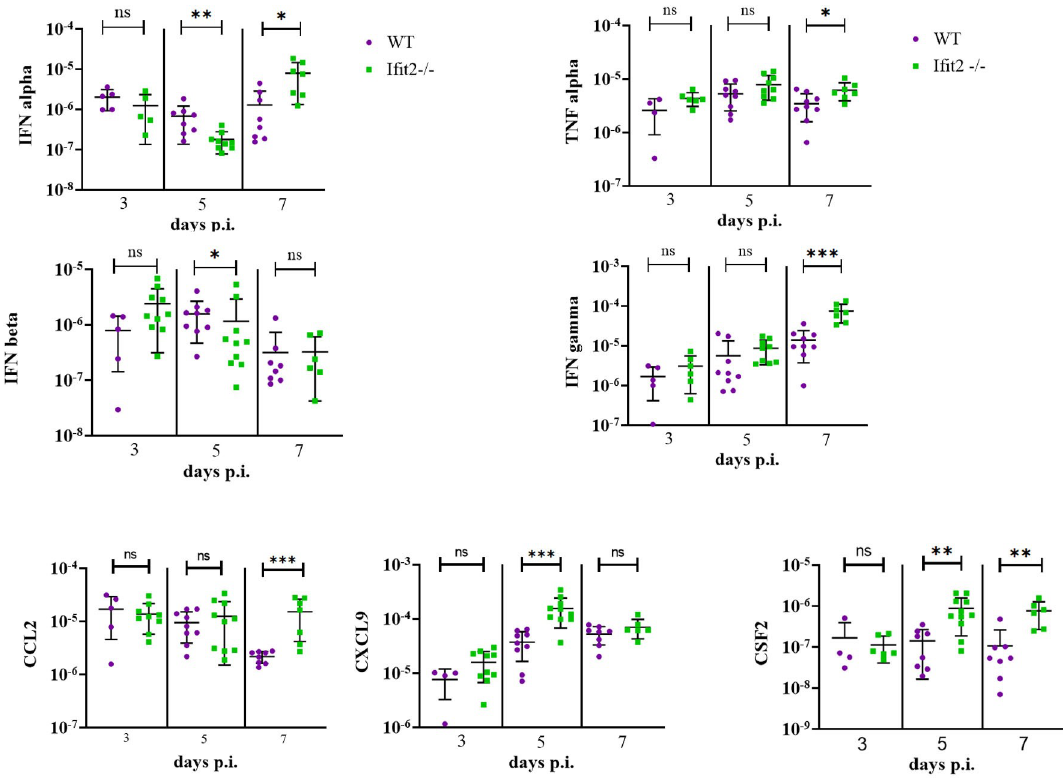
Fig 5. Differential mRNA expression levels of selected proinflammatory cytokines and chemokines in brains of infected Ifit2 -/- and WT mice. RNA extracted from individual brain tissues of RSA59 infected WT and Ifit2 -/- mice at day 3, 5, and 7 p.i. was analysed for mRNA levels of the indicated cytokines and chemokines by Real time PCR. Solid lines represent the mean levels of mRNA expression (n = 4–11). Asterix ( � ) represents differences that are statistically significant by Student’s unpaired t-test analysis (Mann- Whitney Test) ( � P < 0.05, �� P < 0.01, ��� P <